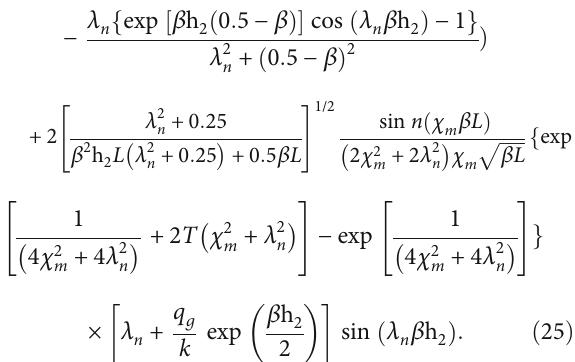
Figure 2: Schematic diagram of the slope limit equilibrium